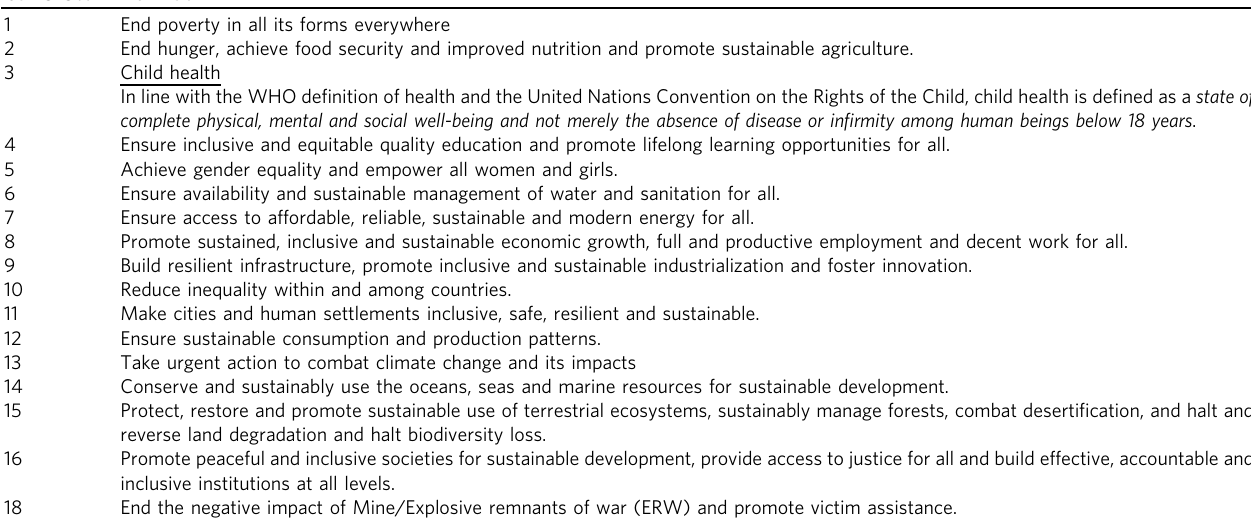
Table 1 List of included Cambodia sustainable development goals and their de fi nitions. CSDG Goal De fi